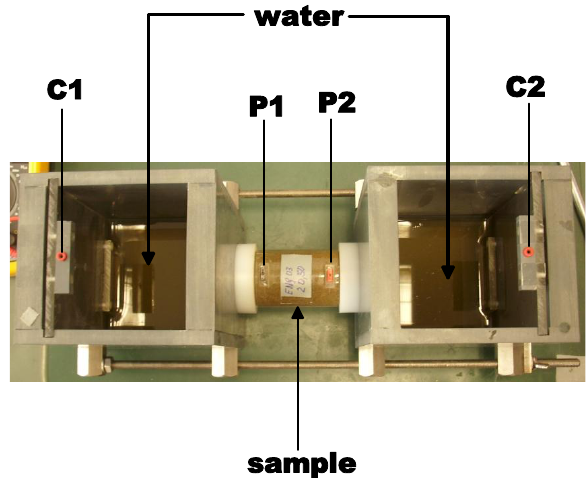
Fig. 5. Layout of laboratory SIP measurements showing how the sample holder is measured using the SIP Fuchs equipment.